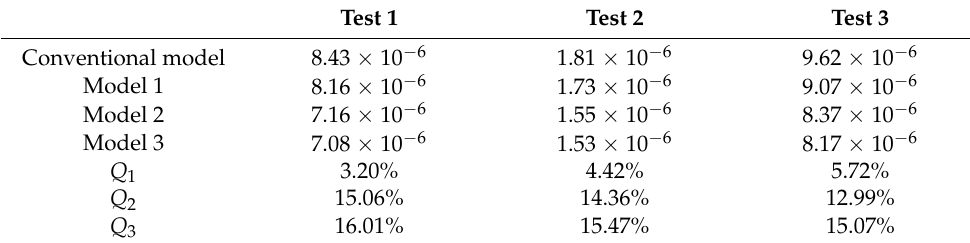
Table 1. Performance comparison between the conventional and novel models.